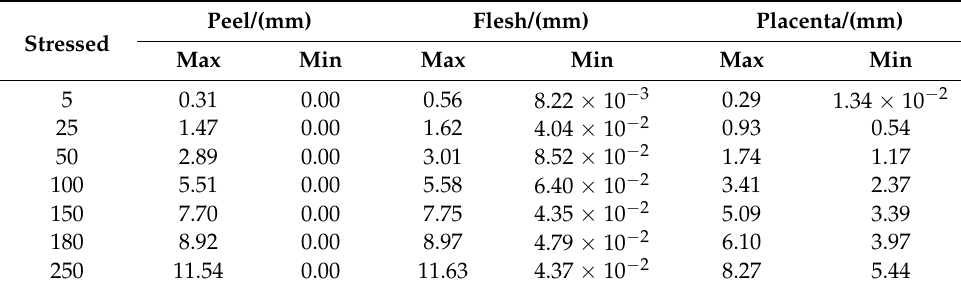
Table 3. Strain statistics table for each part of the